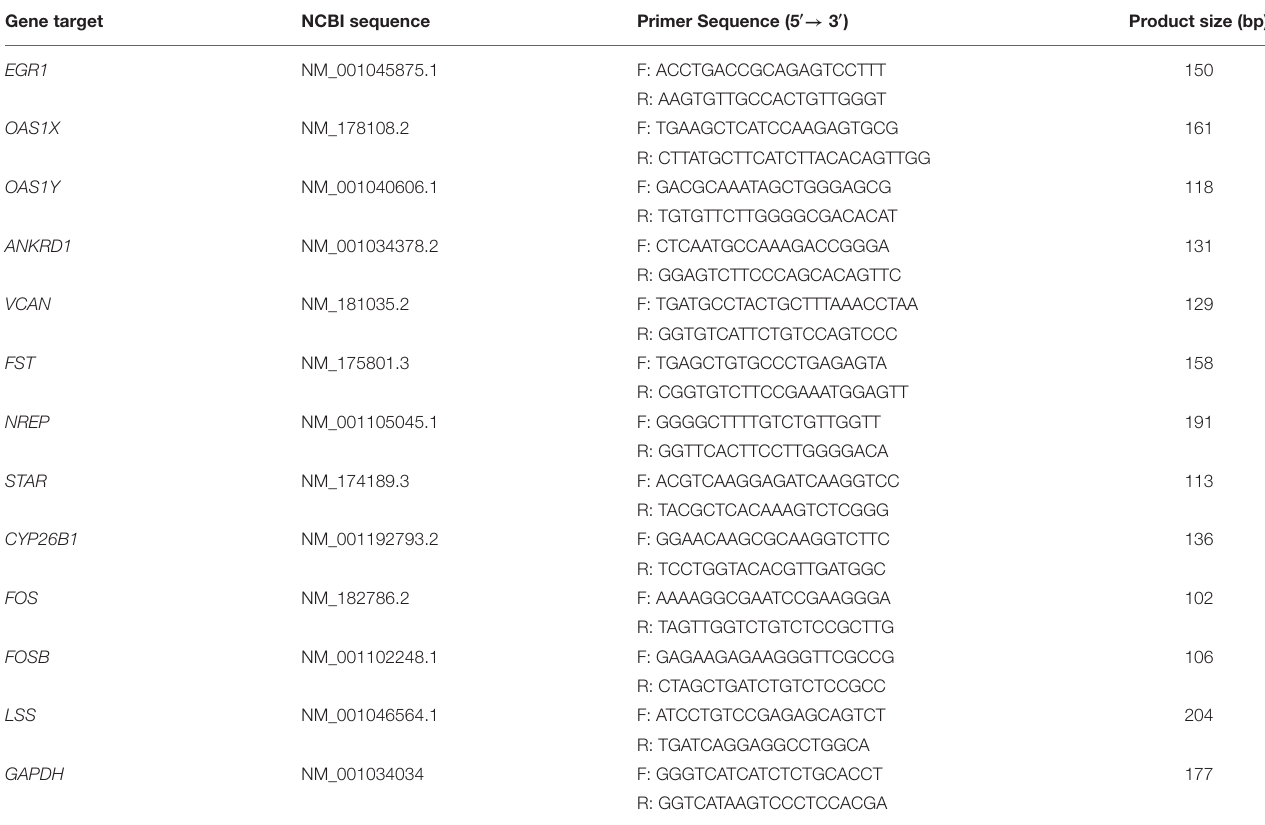
TABLE 1 | Primers used for the qRT-PCR validation of RNA-seq results. Gene